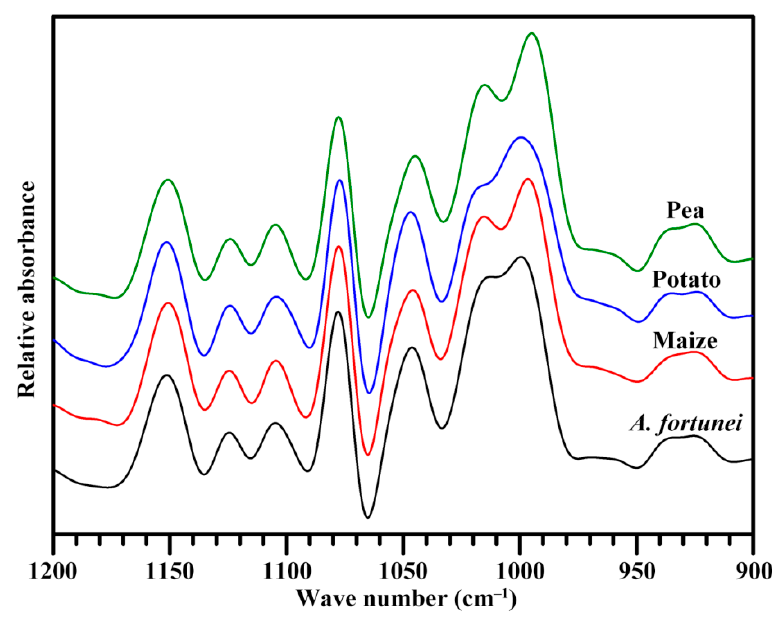
Figure 4. ATR-FTIR spectrum of starch. Table 3. Parameters of short-range ordered structure and lamellar structure of starch.